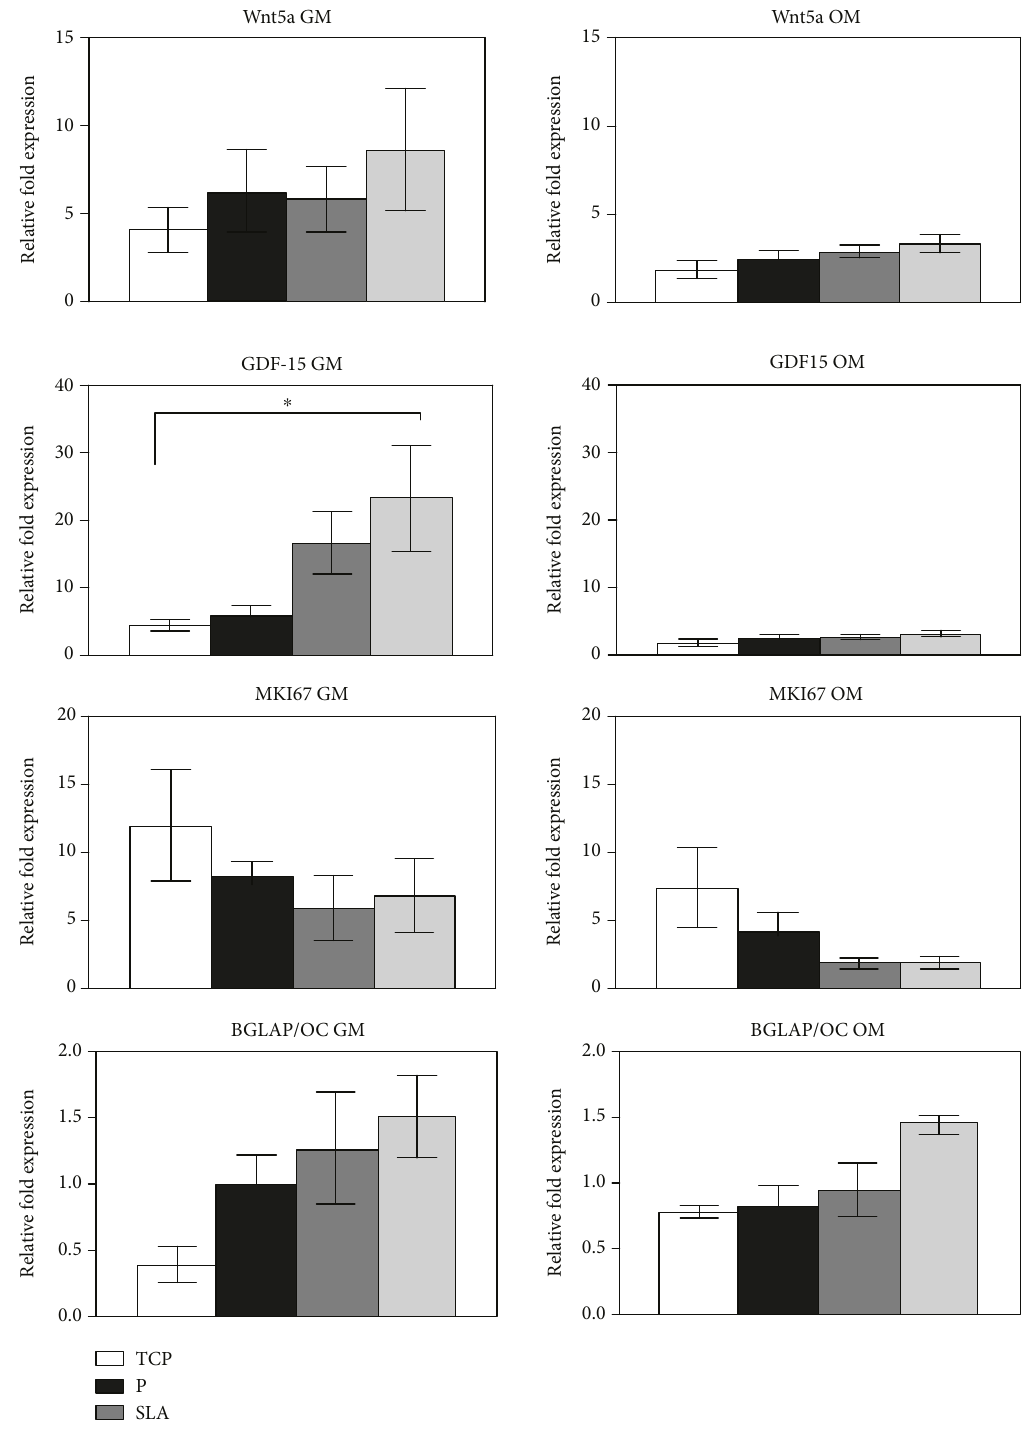
Figure 5: Assessment of Wnt signalling-associated genes with RT-PCR after 24 h. The Wnt molecules GDF-15 and Wnt5a were expressed by cells at higher levels in growth medium (GM) than in osteogenic medium (OM). Both molecules displayed a consistent trend of high expression on modSLA and SLA than P and TCP. Expression of proliferation marker MKI67 was markedly reduced by OM. It was expressed the highest on TCP than Ti surfaces in both medium types with rough surfaces further reducing expression in OM. OC was similar in both types of medium and displayed a trend of higher expression on modSLA. Shown are mean +